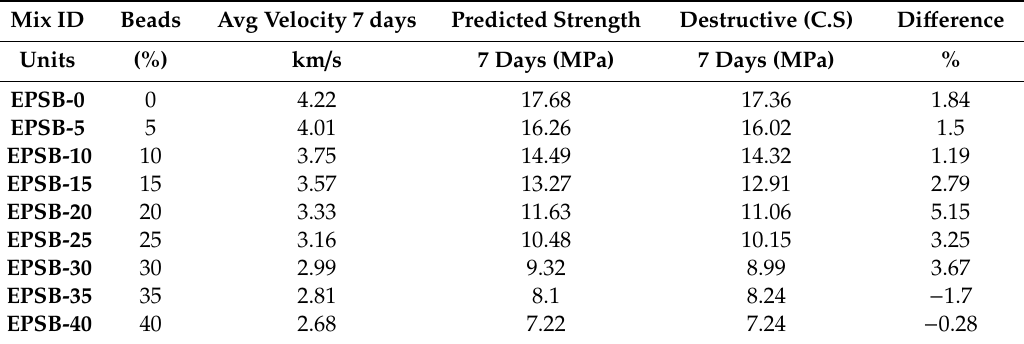
Table 10. Difference between destructive strength and UPV predicted strength at 7 days.